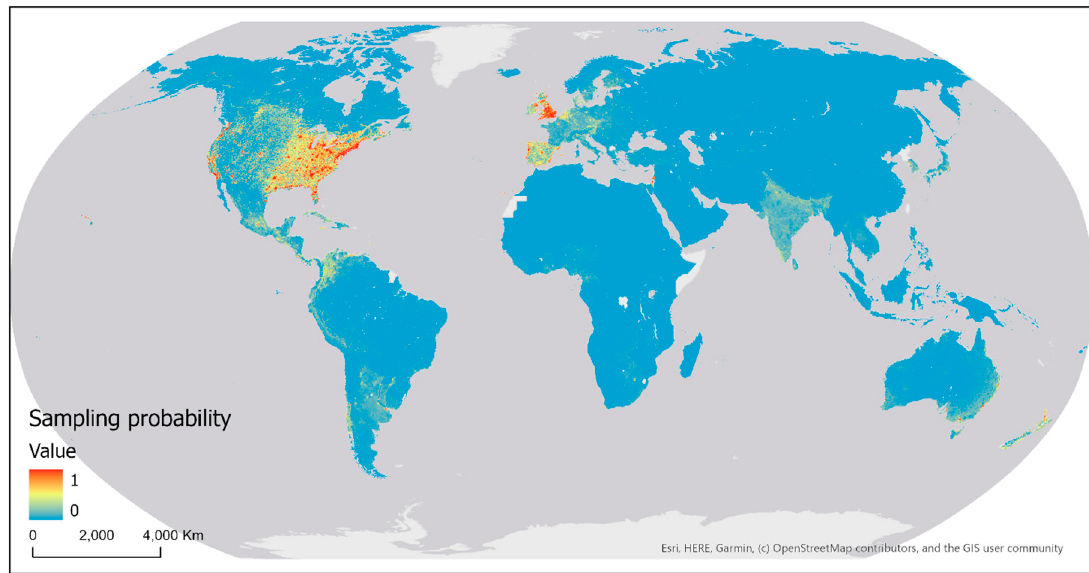
Figure 21. Map of sampling probability of eBird contributors modeled and predicted using Maxent.